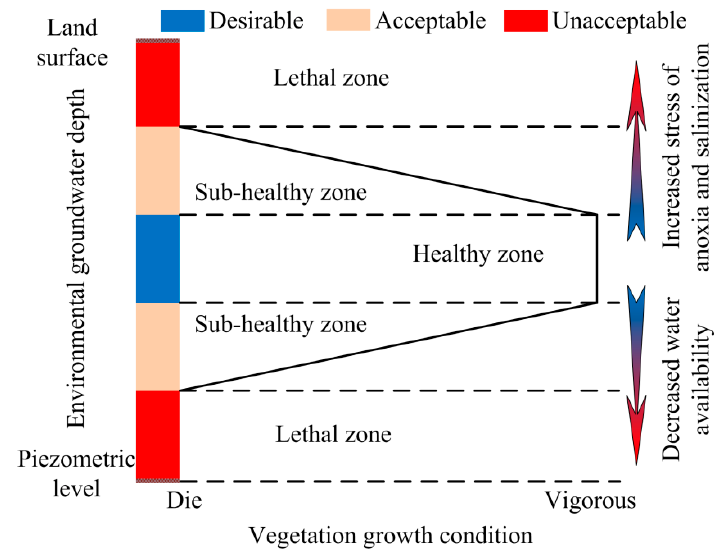
Figure 1. Sketch map for the definition of environmental groundwater depth.